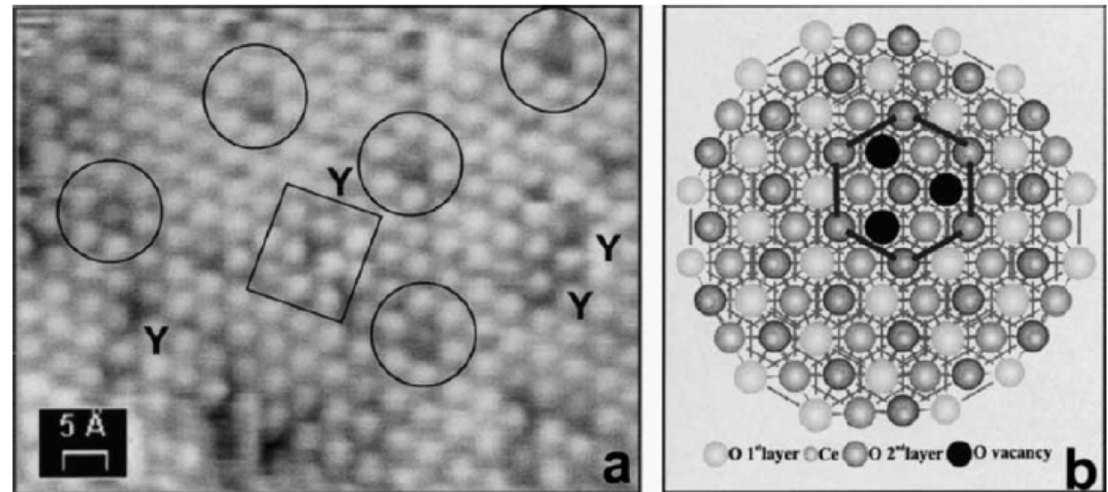
Figure 6. ( a ) High-resolution STM image of the surface of a CeO 2- x island on Rh(111), showing atomic-scale details of the triple oxygen vacancy defects forming a superlattice (circles) and of Y-shaped defects of a different kind (rectangle). ( b ) Model of the triangular defect in terms of three missing O atoms. Reprinted with permission from Castellarin-Cudia et al. [47]. Copyright Elsevier 2004.